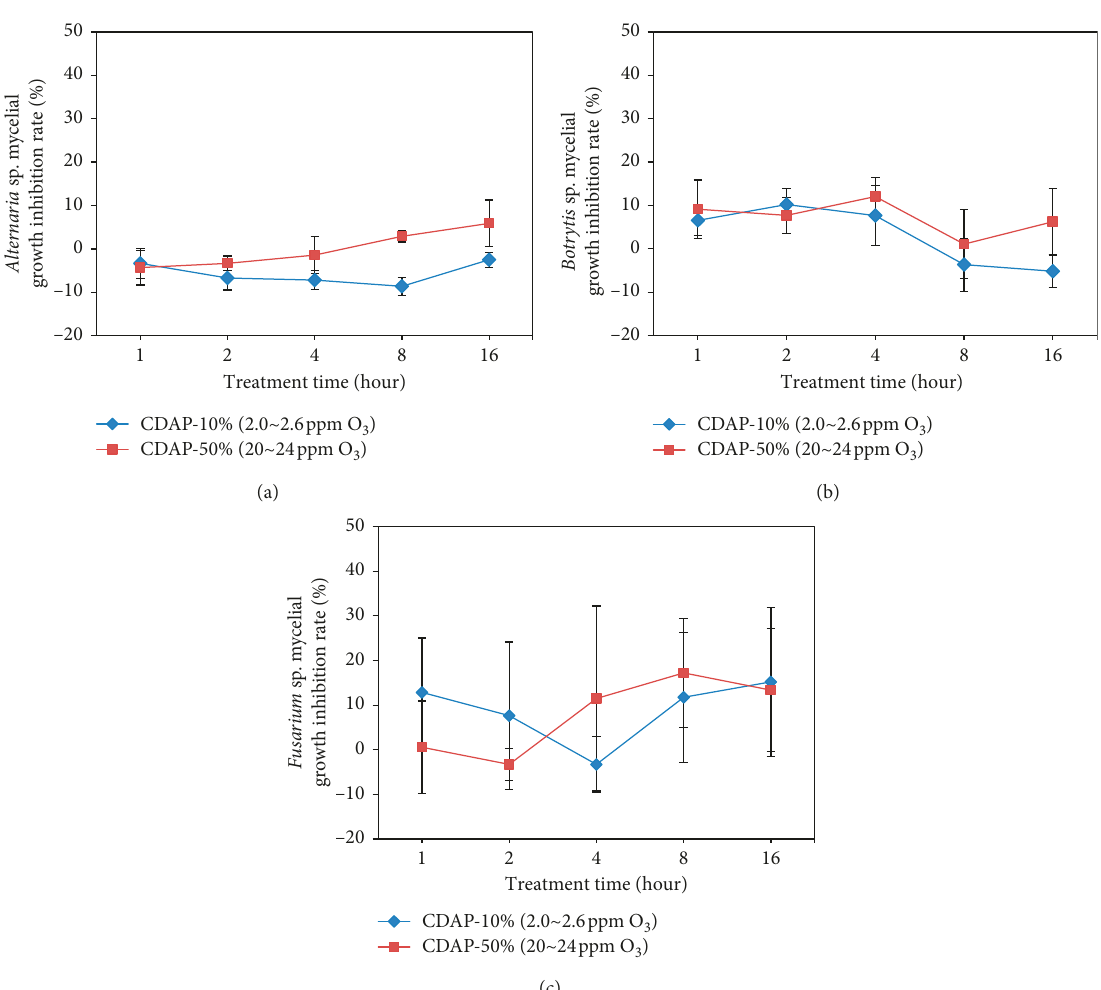
Figure 4: Effect of CDAP treatment time on mycelial growth of Alternaria and Botrytis sp. (a) Mycelial growth of Alternaria sp. 5RD1 after culturing at 25 ° C for 4 days after CDAP treatment, (b) mycelial growth of Botrytis sp. 2RG4 after culturing at 25 ° C for 3 days after CDAP treatment, and (c) mycelial growth of Fusarium sp. 3RC2 after culturing at 25 ° C for 3 days after CDAP treatment. The CDAP-10% and CDAP-50% mean that the plasma operation time is operation on during 1 second/operation off during 1 second (concentration of O 3 is 2.0 ∼ 2.6ppm) at CDAP-10% and operation on during 5 second/operation off during 5 second (concentration of O 3 is 20 ∼ 24 ppm) at CDAP- 50% per hour for 16